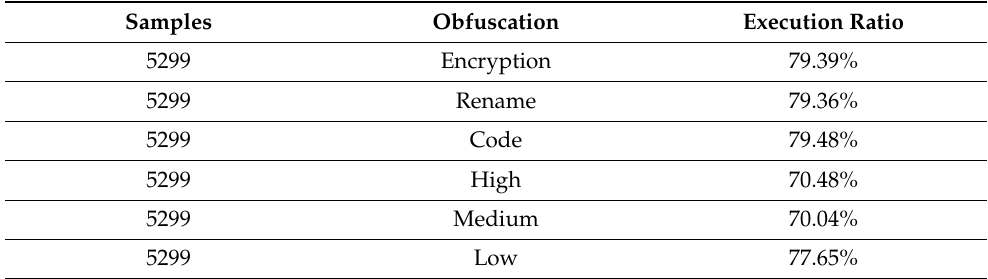
Table 10. Executability of Obfuscated samples seen under VirusTotal Droidy and R2DBox results.